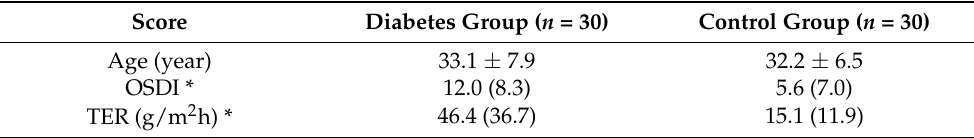
Table 1. The averages (mean ± SD or median (IQR)) for the age, OSDI, and TER scores within the study and the control